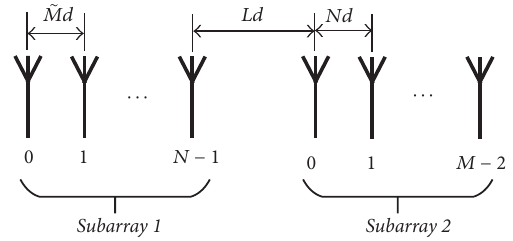
Figure 1: The coprime array with displaced subarrays (CADiS)